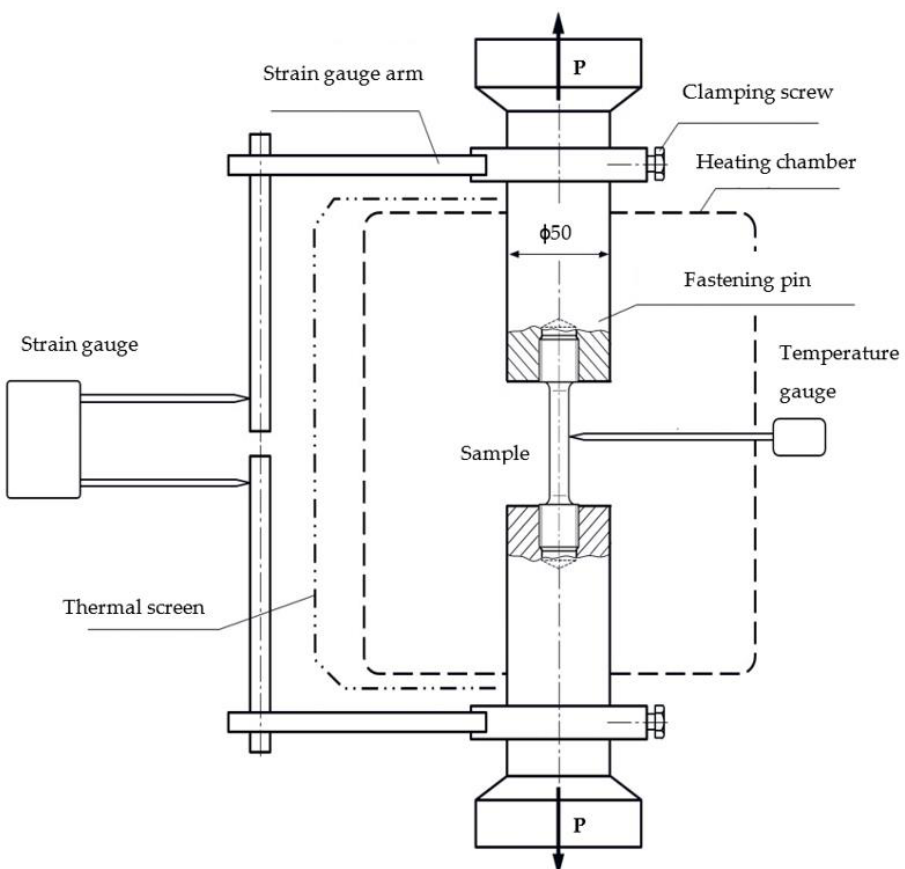
curacy is equal to ±1 °C. The strain gauge (MTS 634 11F-24) has a measurement capability between −2.5 mm and 5 mm, and its measurement class is equal to 0.5 (ISO 9513). The between − 2.5 mm and 5 mm, and its measurement class is equal to 0.5 (ISO 9513). The conversion from an analogue to digital signal was achieved using the L-Card E440 converter verter coupled with the Power Graph 3.3.8 software for storing and analysing data.